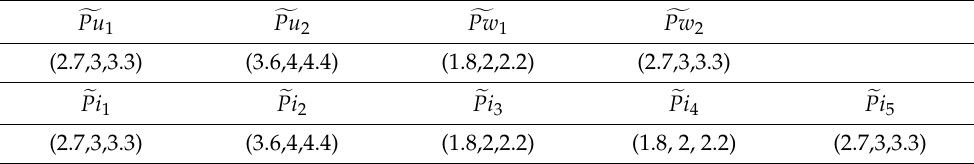
Table 11. Profit from selling reusable, renewable, recovery items per unit (us dollar).